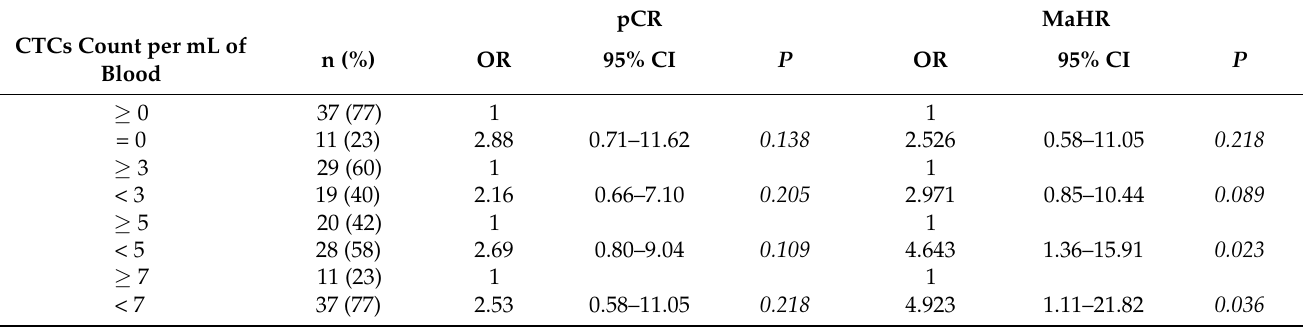
Table 2. Determination of the optimal cutoff value for circulating tumor cells in the assessment of response to neoadjuvant